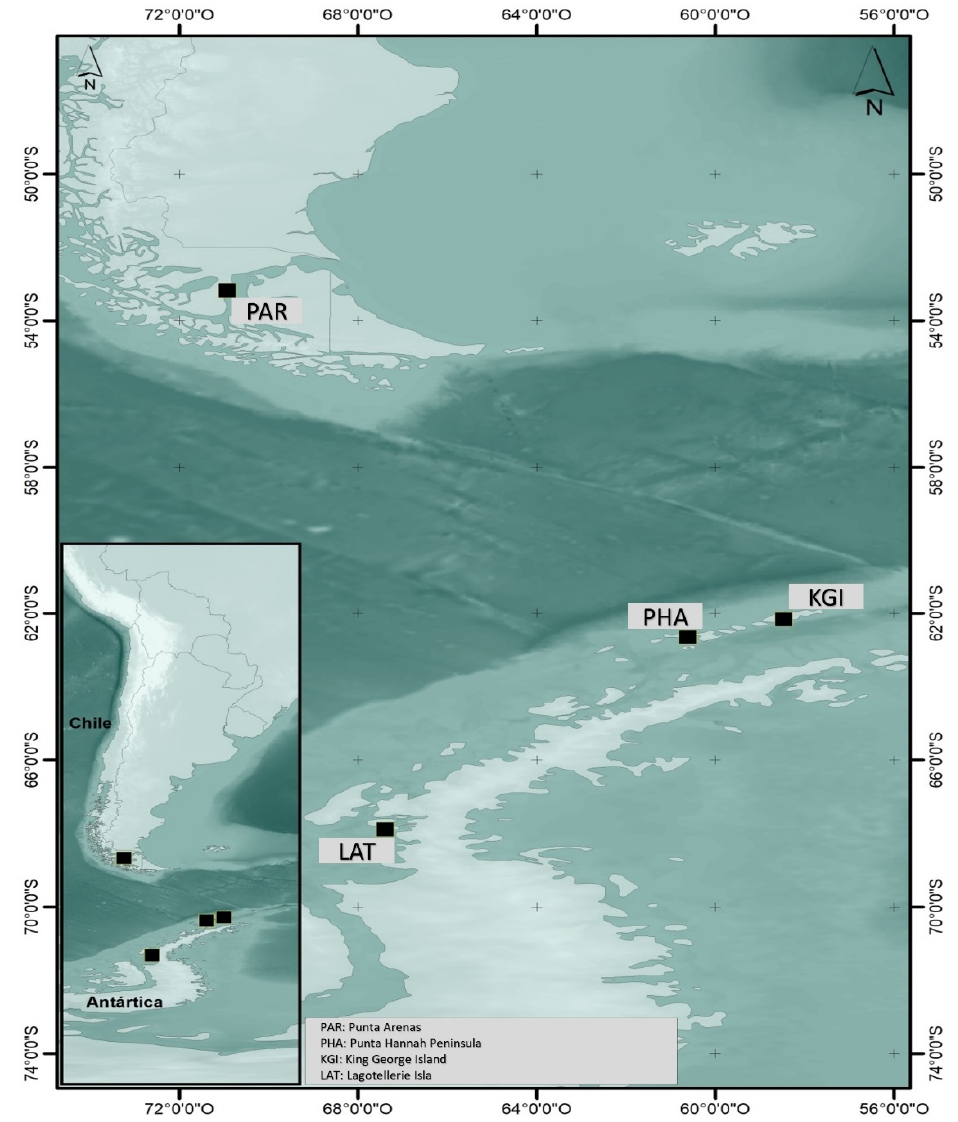
Figure 5. Geographical location of the four zones in which samples were taken of Colobanthus quitensis plants and their soils of